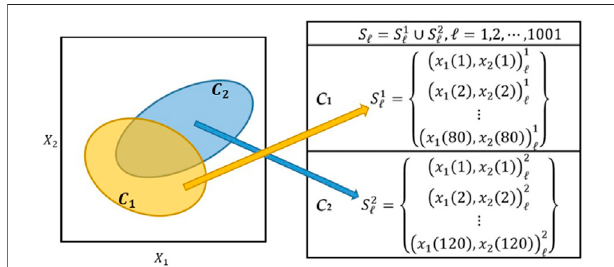
FIGURE 1 | Conceptual illustrations of a two-class bivariate Gaussian distributionand simulatedsampledata sets.Each sampledataset consistsof 80 data points from C 1 and 120 data points from C